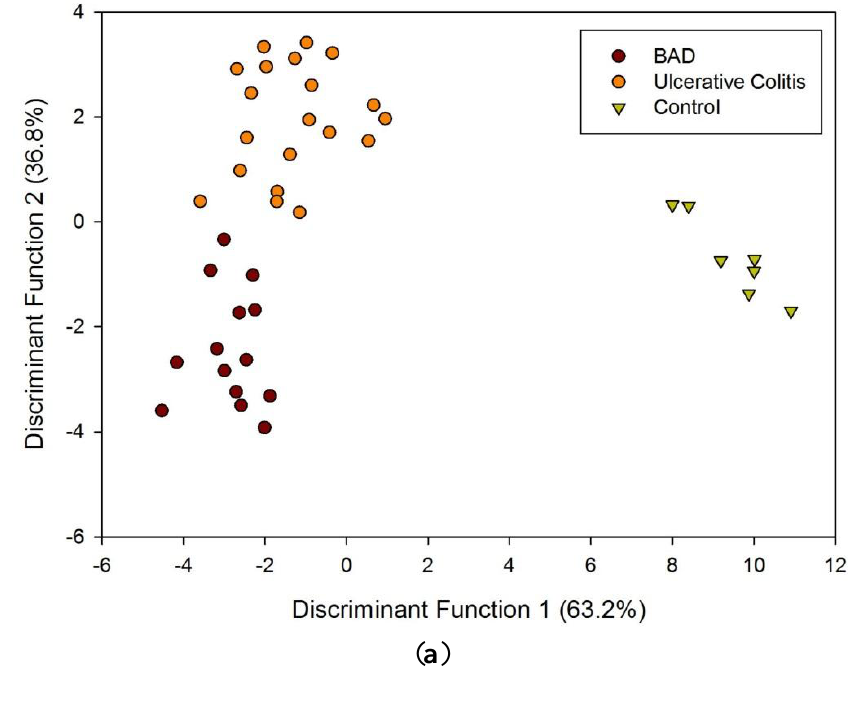
Figure 3. ( a ) Linear Discriminant Analysis of AlphaMOS Fox 4000 results. ( b ) Associated loadings plot for LDA (DF is discriminant